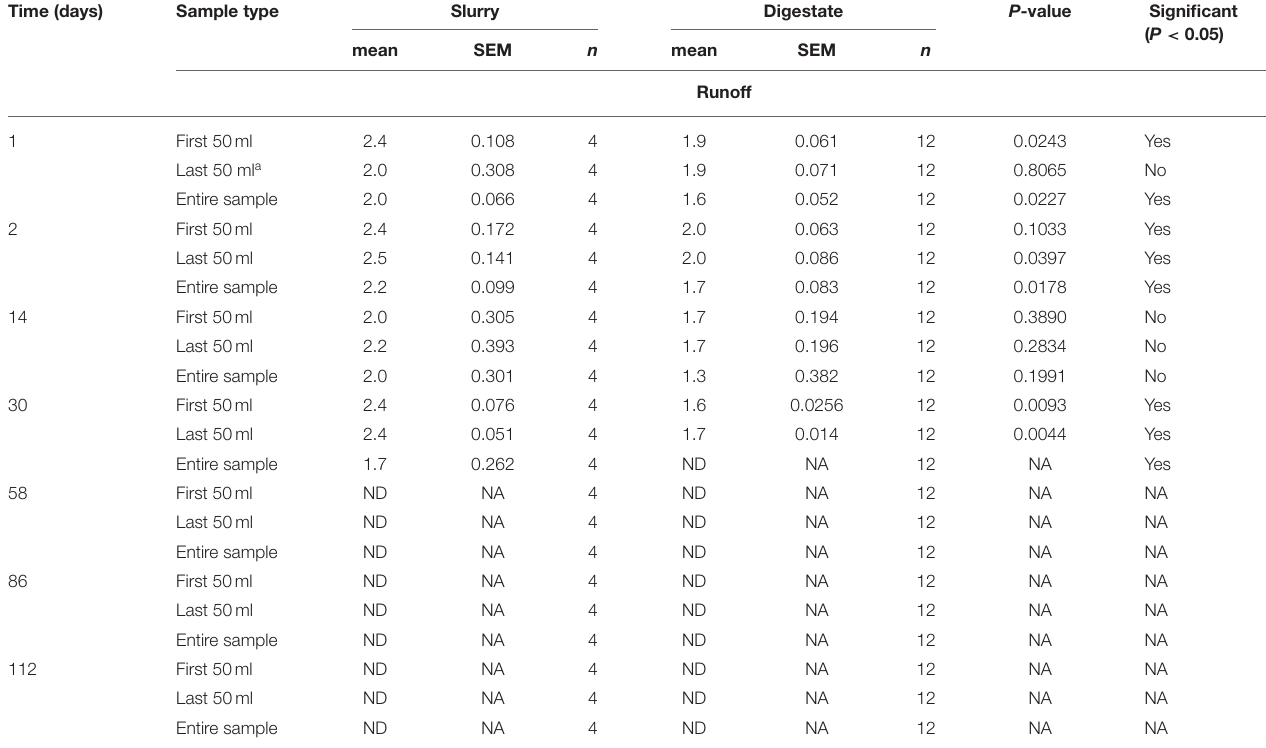
TABLE 4 | The concentrations of L. innocua in leachate during rainfall simulation from inoculated slurry and digestate. Time (days) Sample